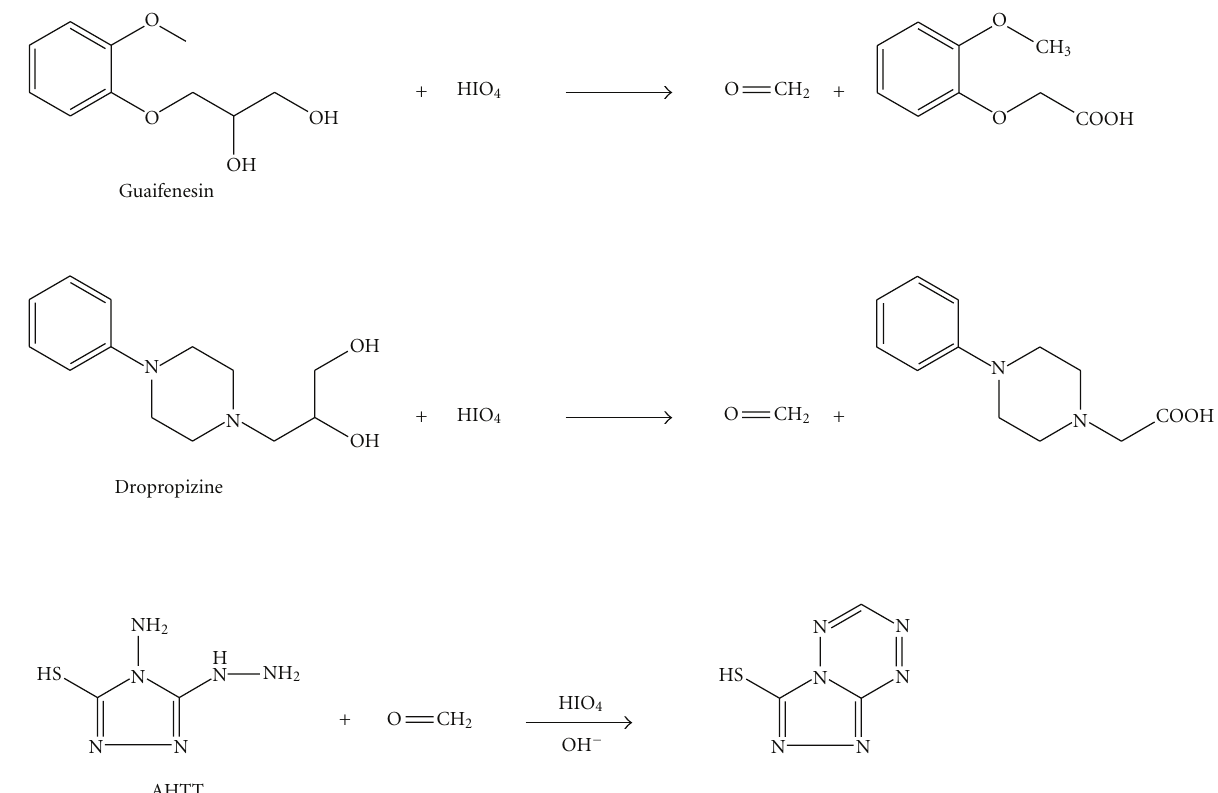
Scheme 1: Reactions involved in analysis of guaifenesin and